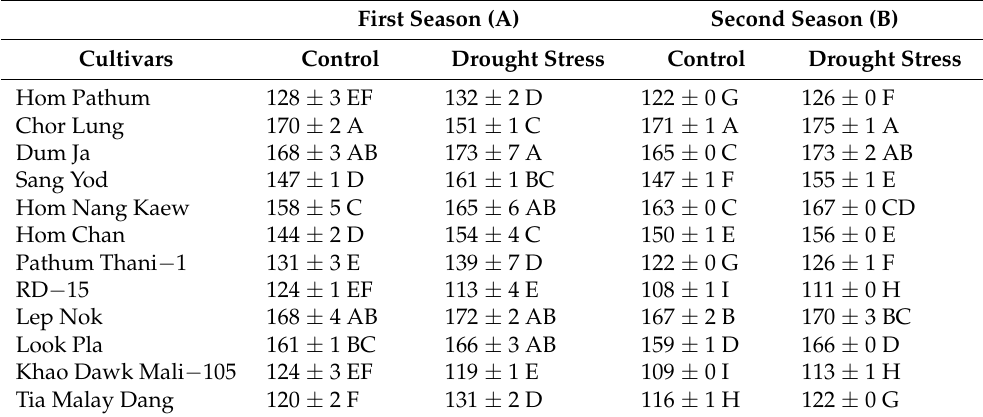
Cultivars Control Drought Stress